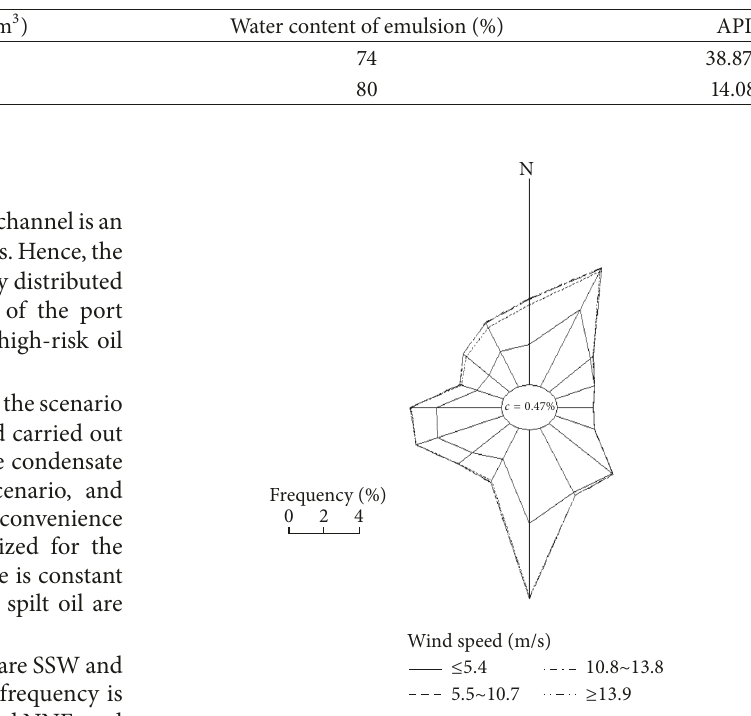
Figure 13: Comparison between the experimental result (a) and the modeled result (b) of the concentration diffusion of the oil slick. Table 5: Properties of the oil.